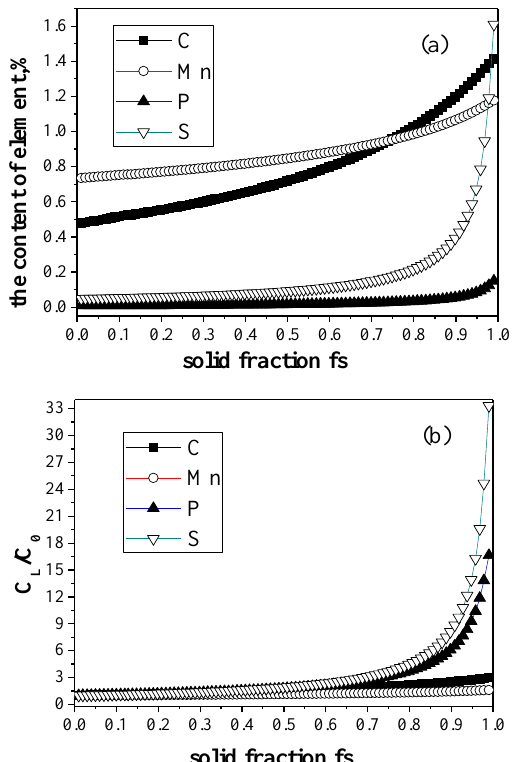
Figure 3. ( a ) Concentration and ( b ) segregation indices of elements C, P, and S in liquid phase at the mushy zone.